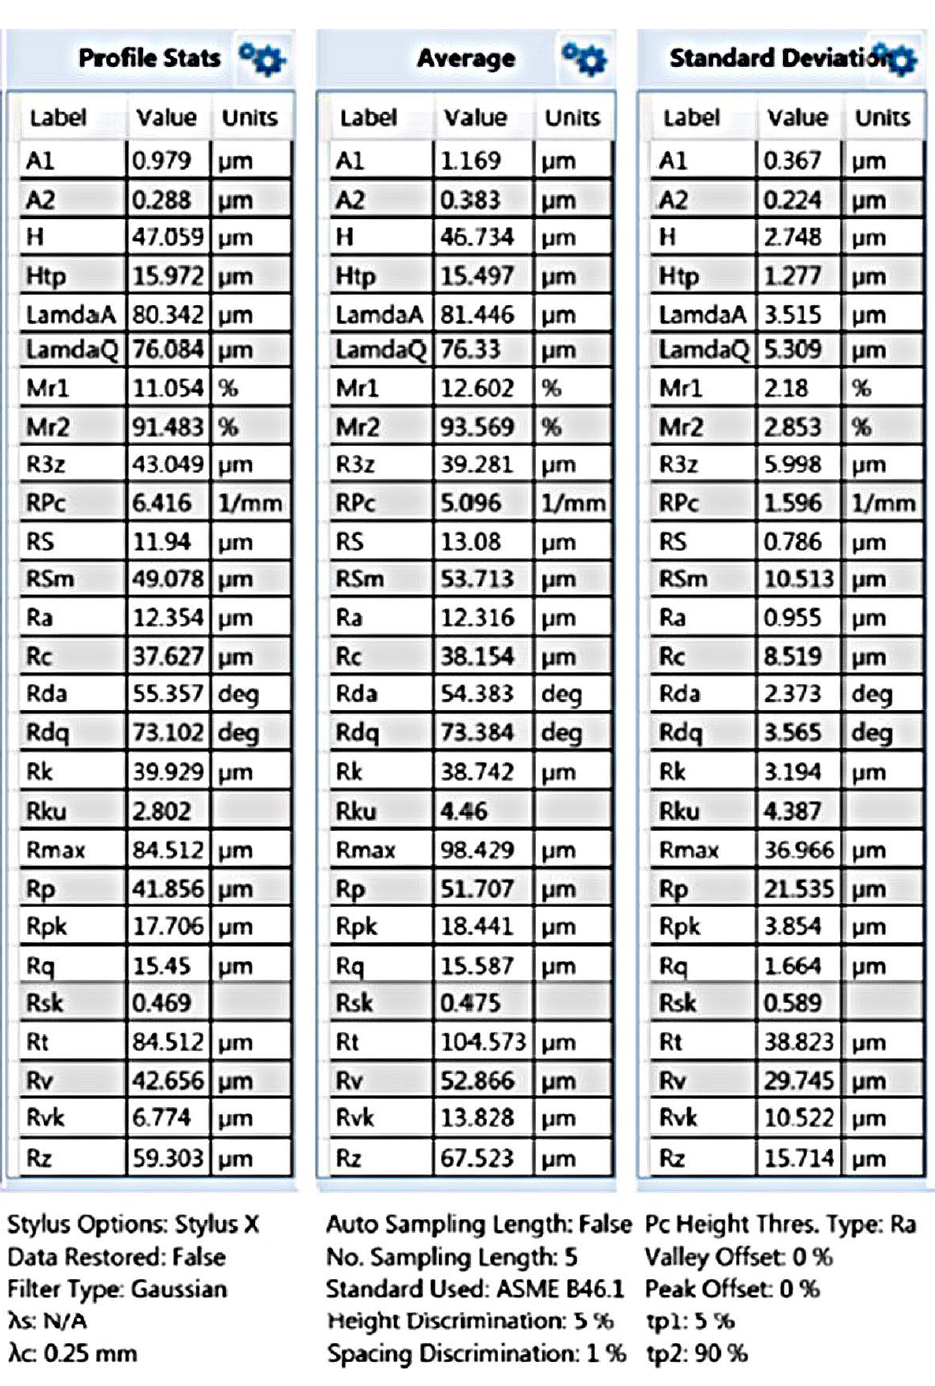
Figure 10. The results of measuring the thread quality after thermal pulse